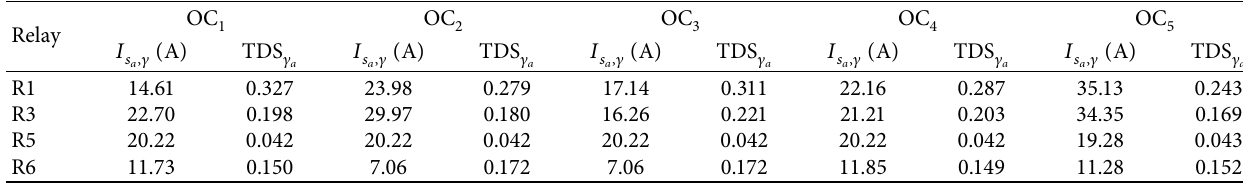
Table 4: Values of relay settings updated for each OC.